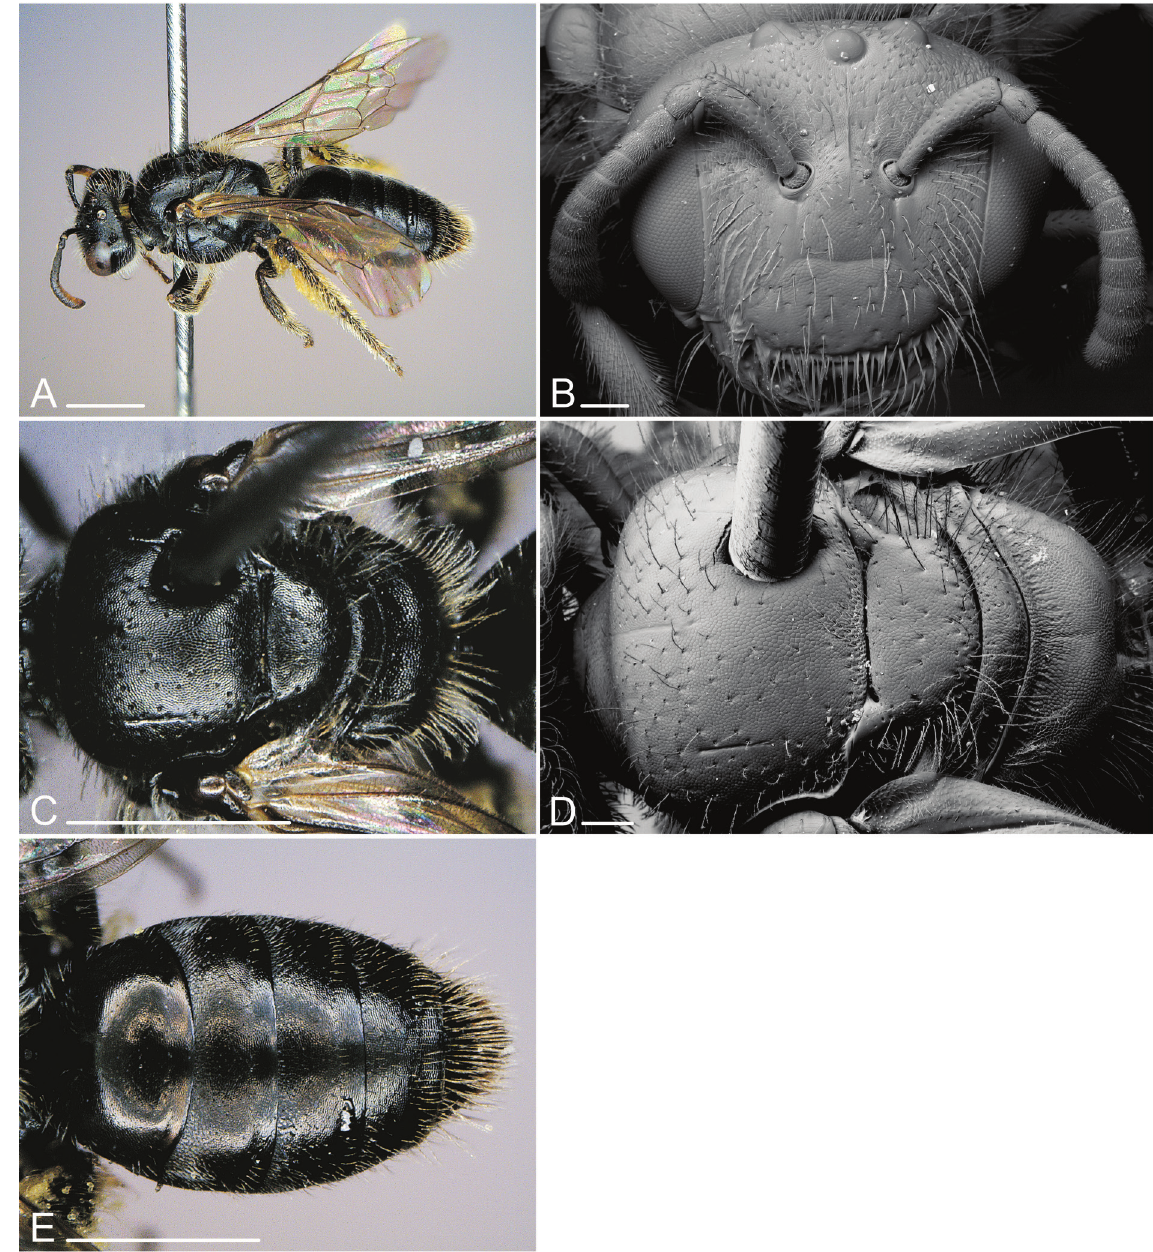
Fig. 25. Scrapter pygmaeus sp. nov., ♀. A . Lateral view. B . Head (SEM). C . Thorax (dorsal view). D . Thorax (dorsal view, SEM). E . Metasoma (dorsal view). Scale bars: photos: 1 mm, SEM: